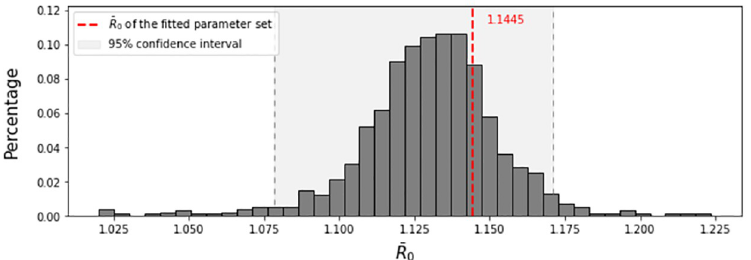
Fig 4. Empirical distribution of � R (1.1445), and its 95% confidence interval is the grey region.